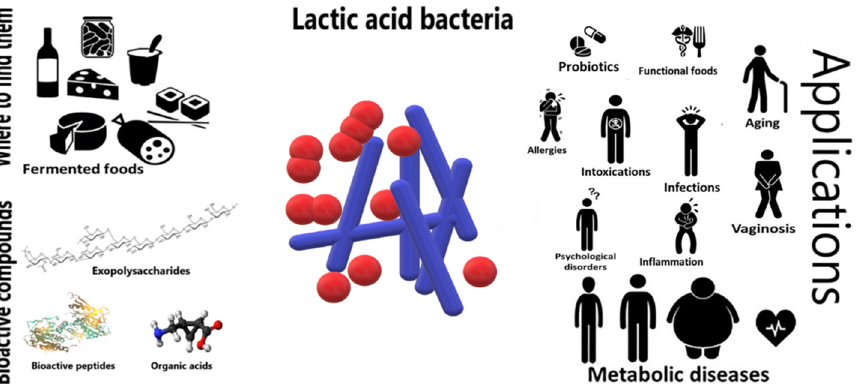
Figure 1. Scheme of LAB bioactive compounds and health-related effects, adapted with permission from [39] Copyright © 2018 George, Daniel, Thomas, Singer, Guilbaud, Tessier, Revol-Junelles, Borges and Foligné.